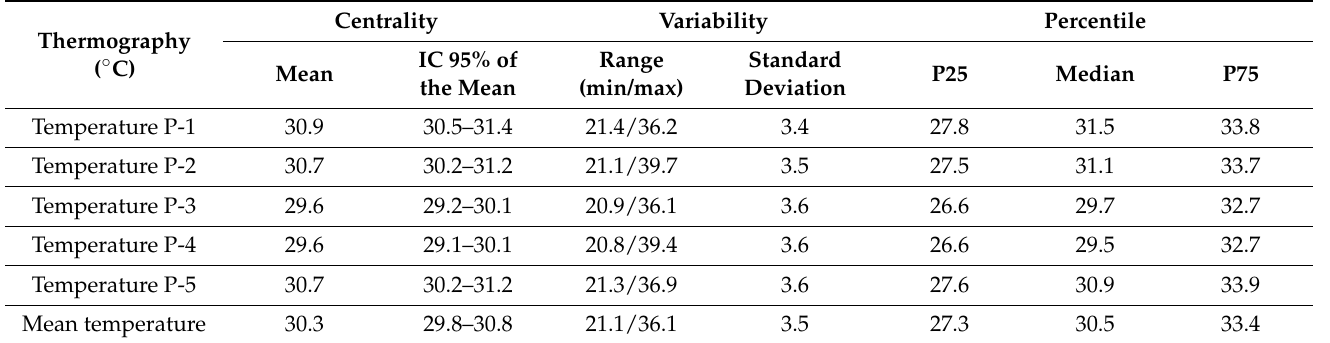
Table 6. Relation of results of thermography variables and prevalence of dermatophyte and yeast infection.